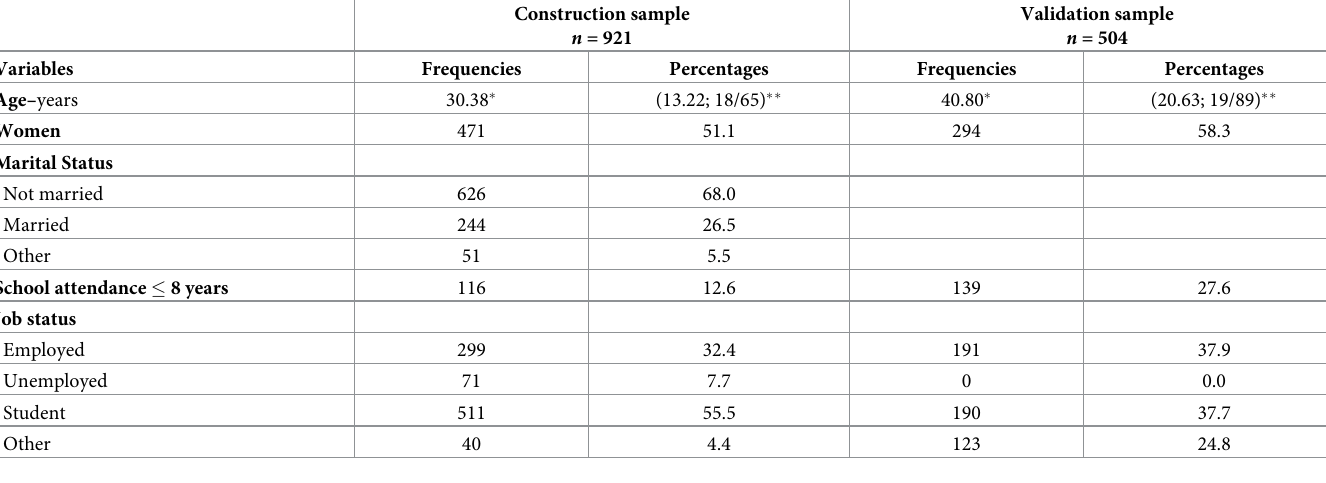
Table 1. Sociodemographic characteristics of the construction and validation